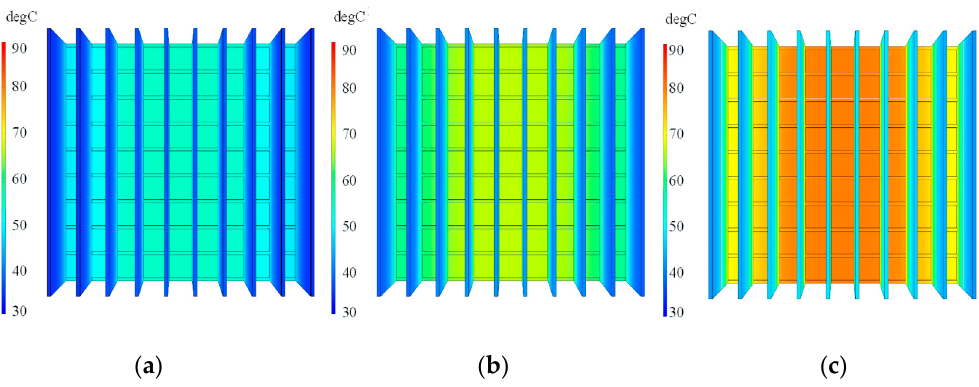
Figure 4. The temperature distribution of PCM heat sink under three different maximum forward average currents at 400 s. ( a ) The temperature distribution of the PCM heat sink at 300 A; ( b ) The temperature distribution of the PCM heat sink at 400 A; ( c ) The temperature distribution of the PCM heat sink at 515 A.